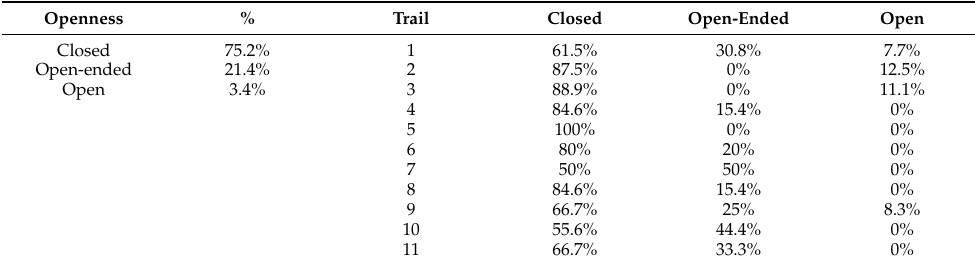
Table 8. Openness of tasks and breakdown for each